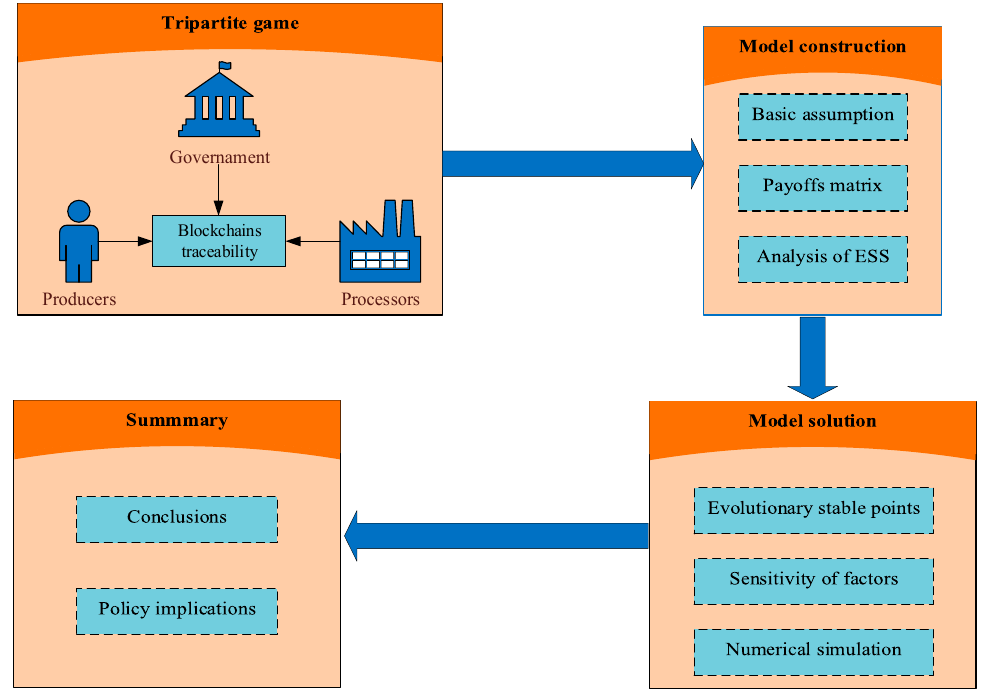
Figure 1. The tripartite decision framework for traceability in agricultural supply chains.